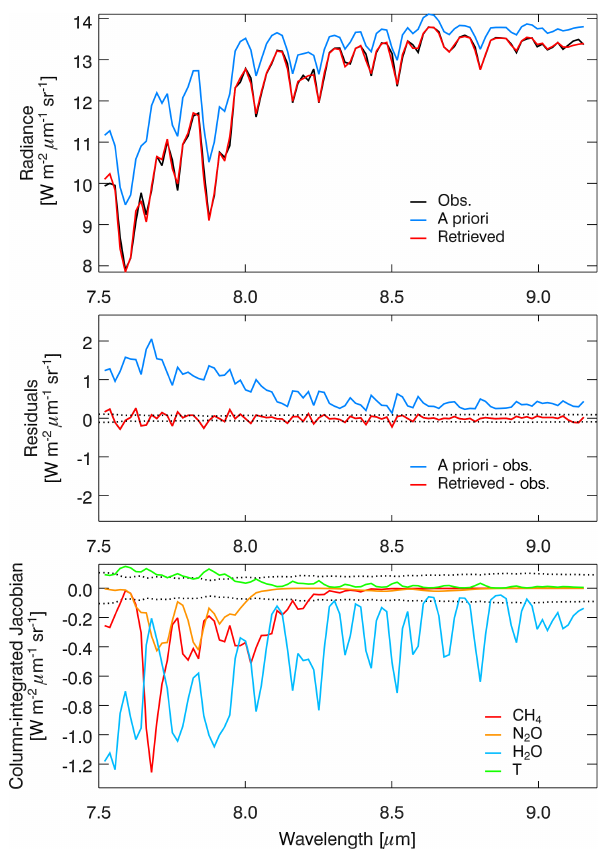
Figure 1. The spectral window for CH 4 retrievals. Top: HyTES- measured radiances (black) and two model-calculated radiances from a priori (blue) and retrieved states (red). Middle: residuals to the observations. Bottom: column-integrated Jacobians (sensitivity of radiance to CH 4 and key interfering parameters). Noise levels are plotted by black dotted lines in both middle and bottom